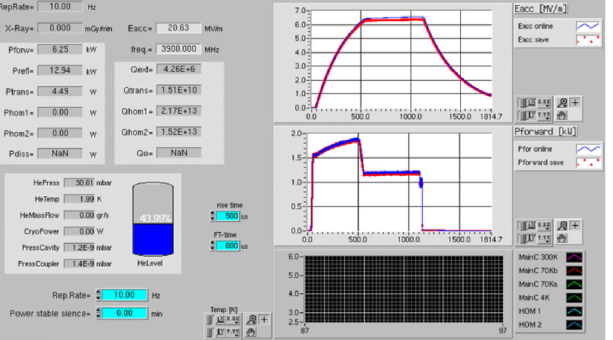
FIG. 8. Typical pulse measured during the long stable operation at 20 MV = m, 10 Hz operation with a 0.5 ms fill time and 0.6 ms flat top pulse in feed forward mode. E (top plot) and forward acc power (bottom plot) are displayed in arbitrary units. Power readings and computed Q values are shown in the left part ext of the control system panel. FIG. 9. Comparison between the vertical test measurements of the cavity at INFN-LASA and the qualification test in the horizontal cryostat at the